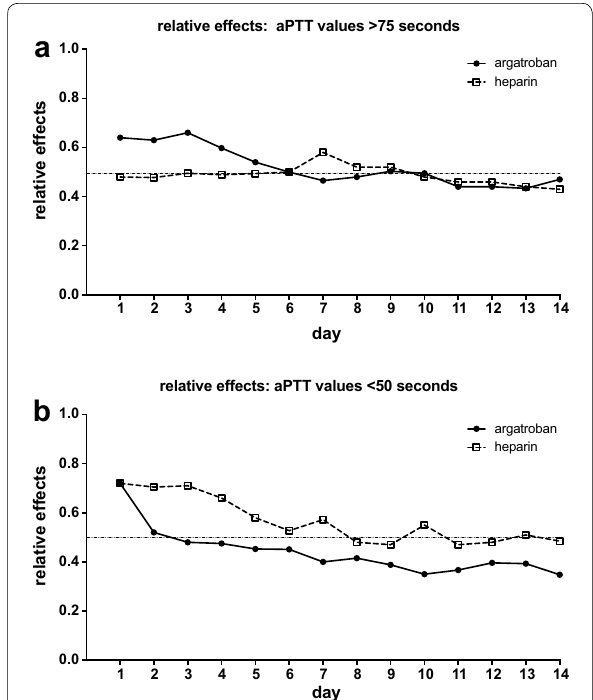
Fig. 3 a Exceedances of aPTT values >75 s over the course of time in ARDS patients undergoing extracorporeal lung support with either argatroban or heparin as anticoagulant; depicted as relative effect over time; argatroban **** p < 0.0001; heparin p 0.26. b aPTT values = below 50 s over the course of time, depicted as relative effect over time; argatroban and heparin **** p < 0.0001. The relative effect does not represent the measured values of that parameter, but presents (on a scale of 0–1) the treatment effect of the specific group, relative to all groups and therefore to a ‘mean’ treatment effect. Multivariate nonparametric analysis for longitudinal data (MANOVA; Brunner’s